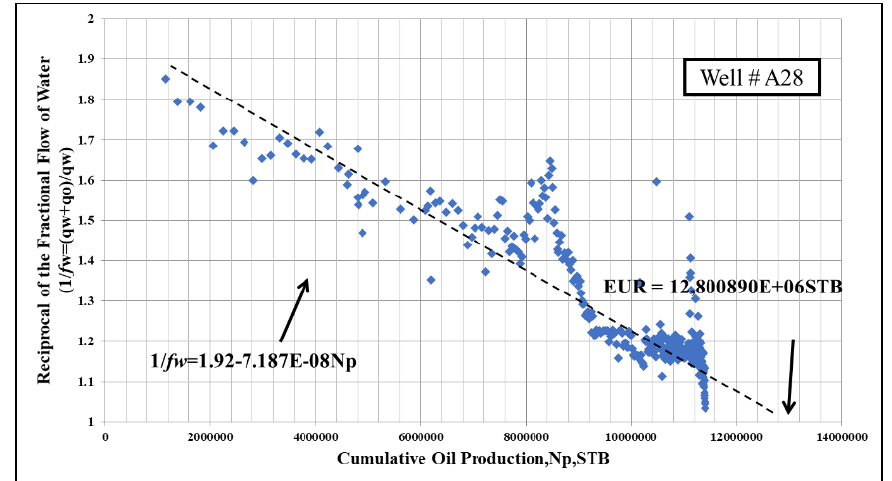
Figure 19. Reciprocal of fractional flow of water versus cumulative oil production for well